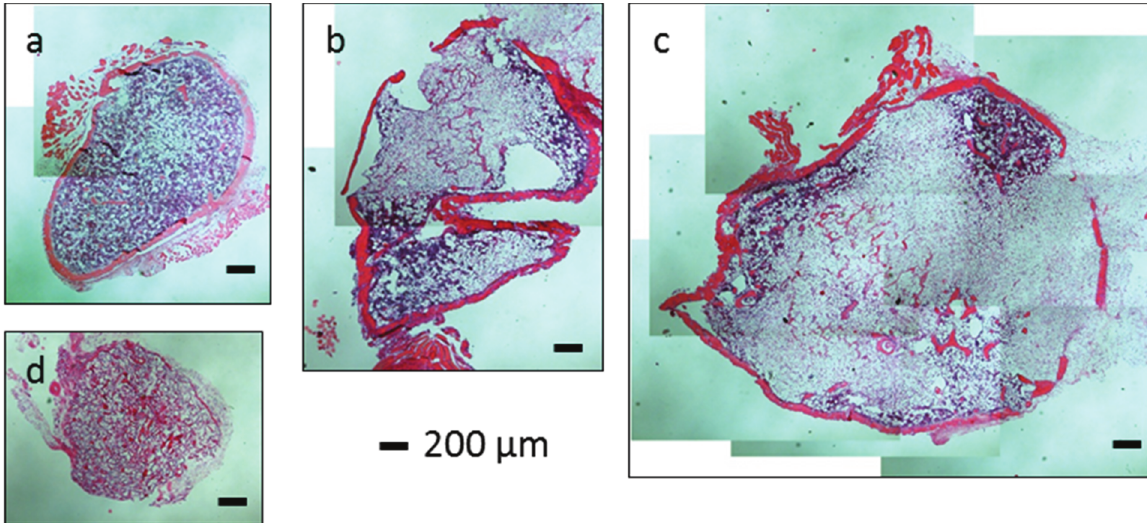
Figure 6. Active BMP-2 found on CS-TPP nanoparticle coated titanium substrates after 2 days quantified via BRE luciferase test. Shown are the results of three different experimental runs with triplicate samples tested with and without lysozyme for particle degradation.